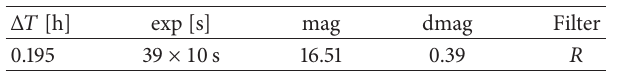
Table 3: GRB 050525A: observing log of